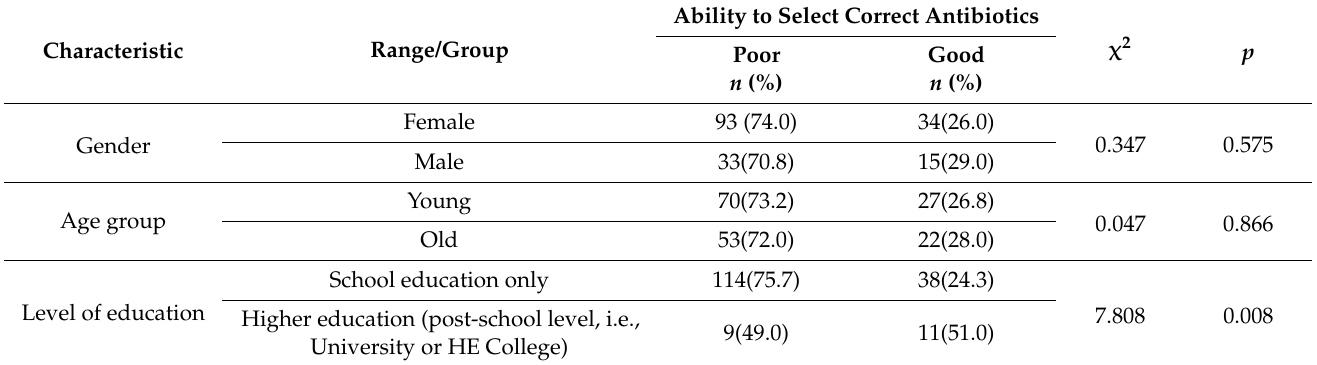
Table 4. Association between respondents’ demographics and ability to correctly select antibiotics from a given list of medicines, by the urban community.